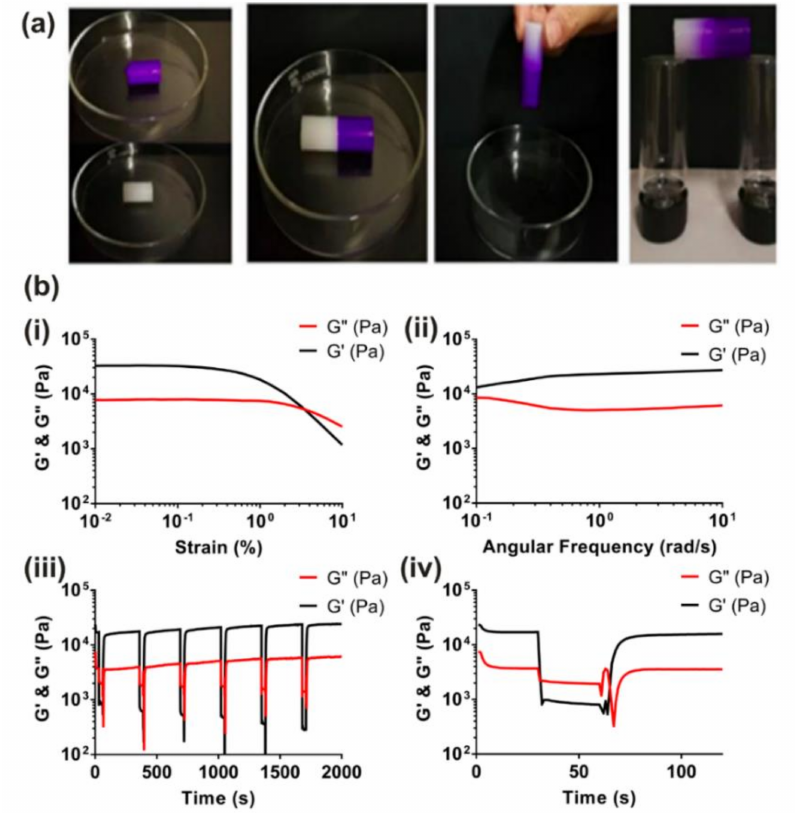
Figure 9. ( a ) Illustration of the self-healing properties of a 2.0% w / v hydrogel formed from a D -gluconic acetal-based derivative using hydrogel pieces with and without methylene blue dye. ( b ) Rheological properties of a shear-thinning and self-healing supramolecular hydrogel based on a bis-urea derivative, showing (i) a strain sweep, (ii) a frequency sweep, and (iii, iv) dynamic strain amplitude tests. Reproduced ( a ) under the terms of the Creative Commons CC BY License from [60] ©2019 The Authors; published by Springer Nature and ( b ) with permission from [14] ©2019, Royal Society of